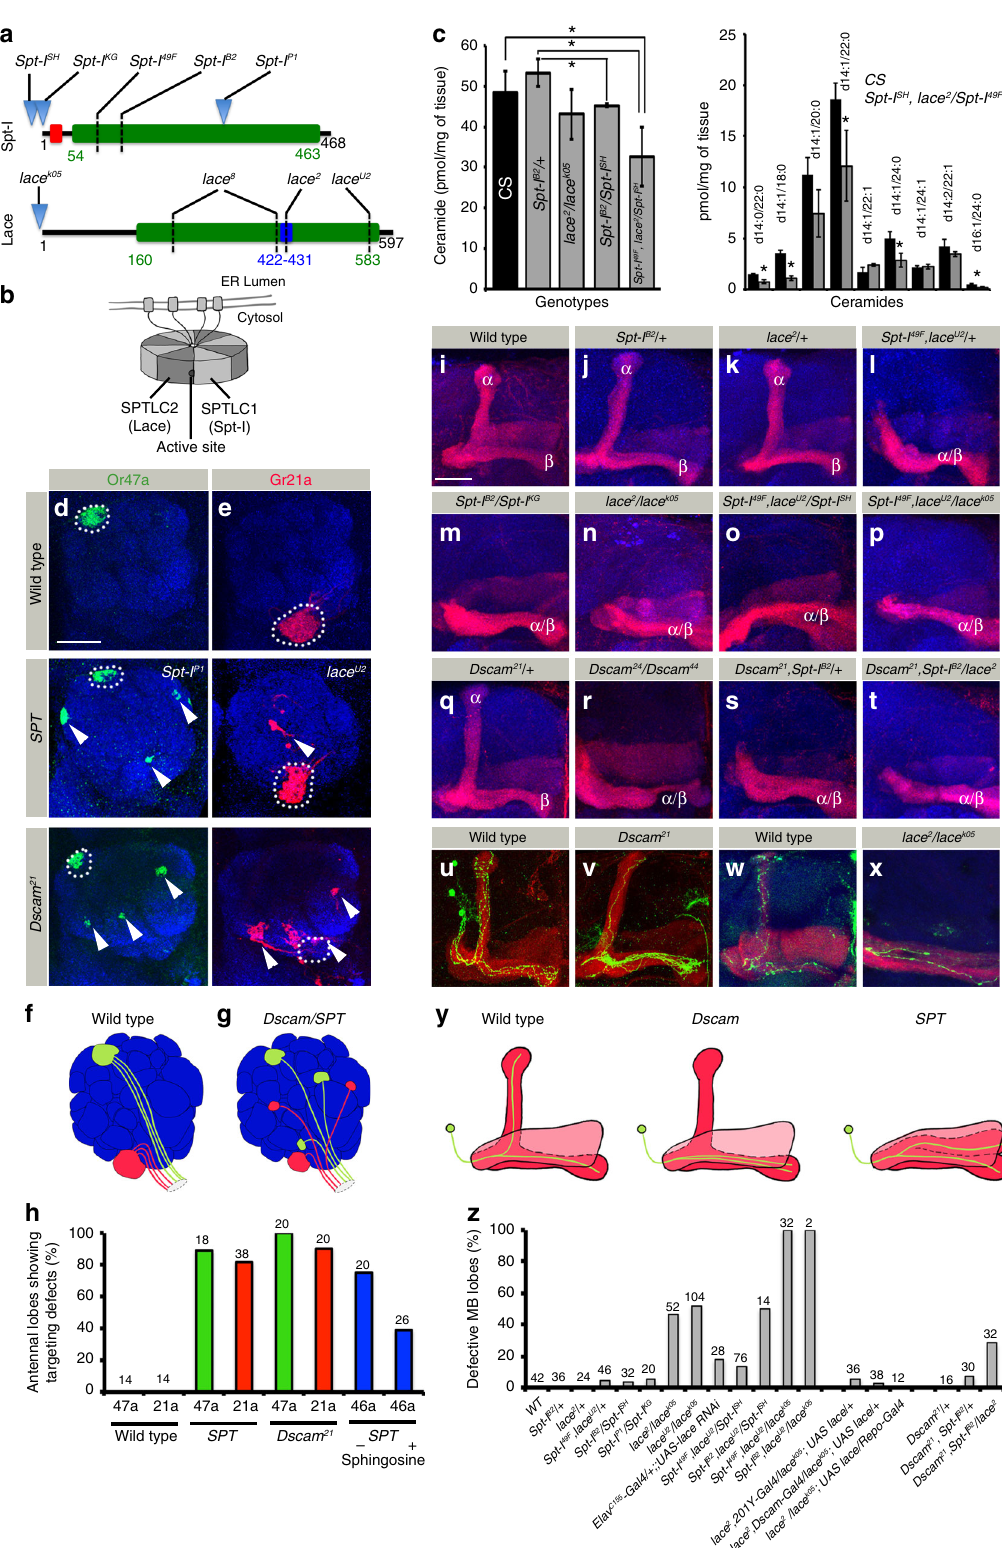
lace 2 /lace k05 Spt-I 49F ,lace U2 /Spt-I SH Spt-I 49F ,lace U2 /lace k05 Spt-I B2 /Spt-I KG